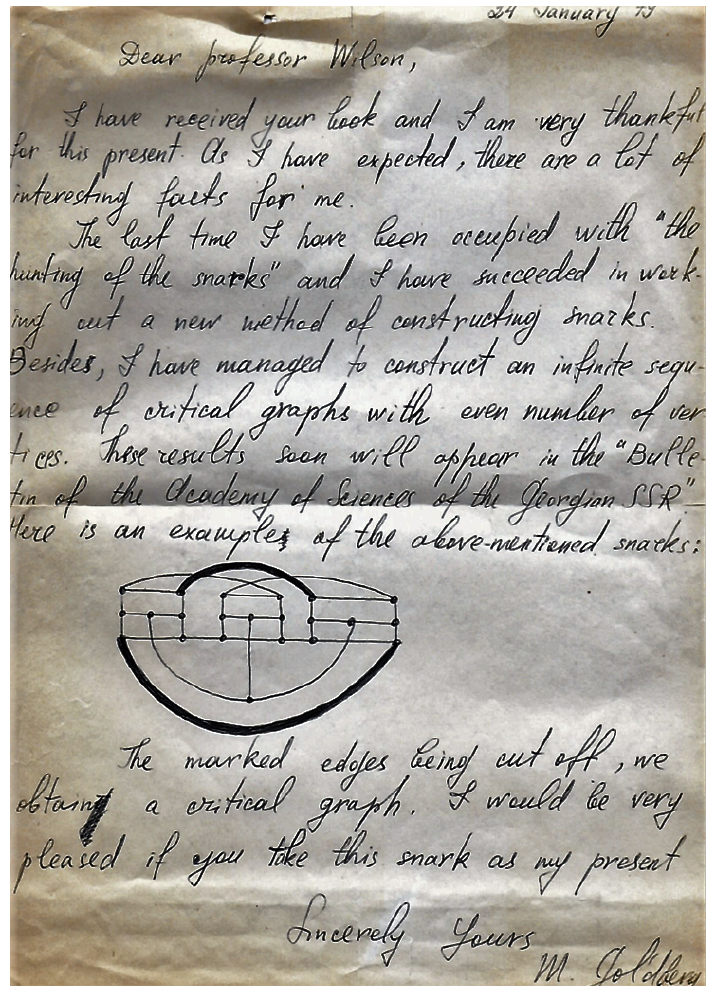
Figure 6: A letter from Mark Goldberg to Robin Wilson, January